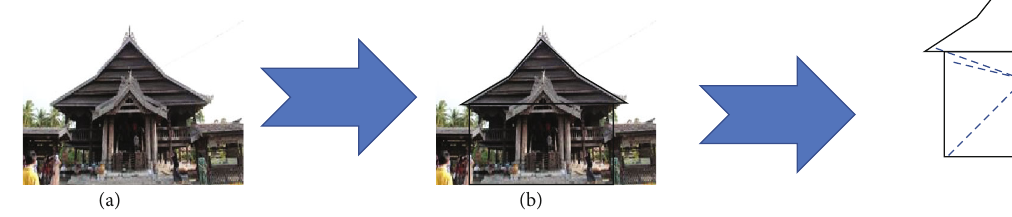
Figure 49: The construction of building number ̂ 5